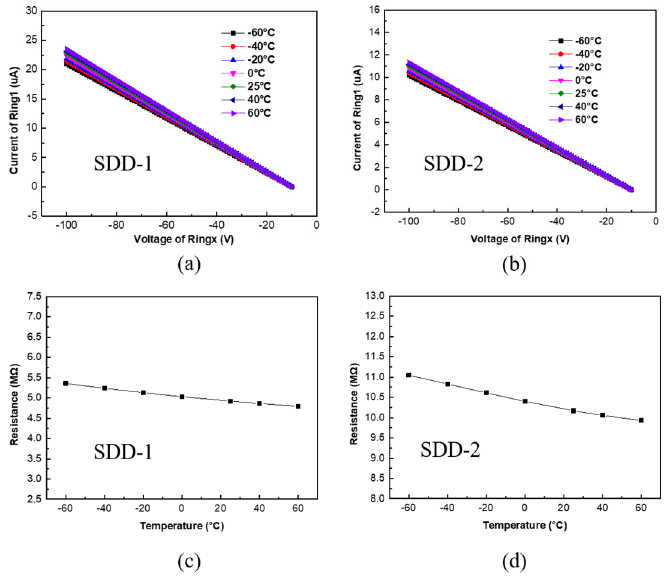
Figure 8. ( a , b ) The IV characteristics of voltage dividers of SDD-1 and SDD-2 at the temperature range from − 60 °C to 60 °C, respectively. ( c , d ) The variation of voltage divider’s resistance of SDD- 1 and SDD-2 at the temperature range from − 60 °C to 60 °C, respectively.